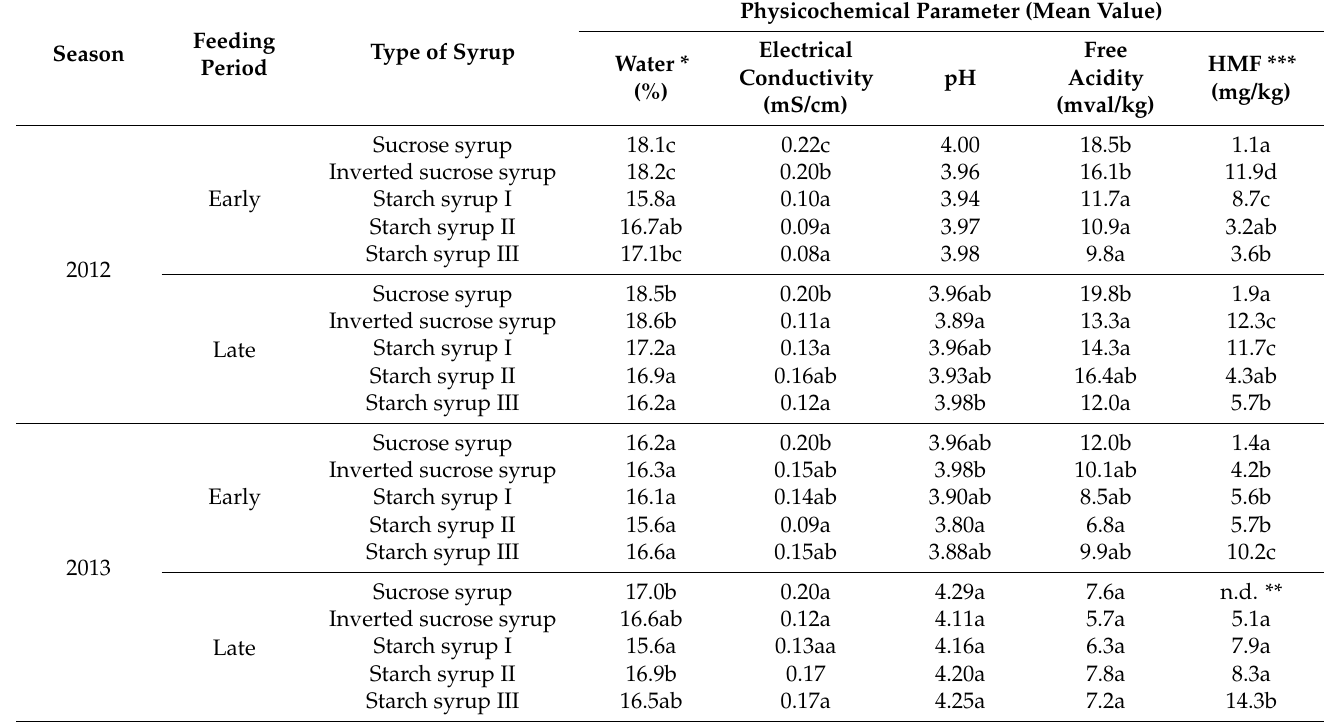
Table 6. Comparison of physicochemical composition of winter stores ( n = 5) produced by bees fed with different types of syrup in 2012 and